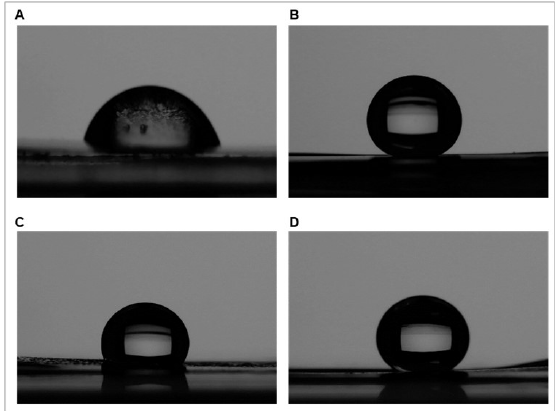
Figure 1. The water contact angle of poly(lactic acid) film ( A ) without the graphene/TiO 2 coating, ( B ) with the graphene/TiO 2 coating, ( C ) with the graphene coating, and ( D ) with the TiO 2 coating on the surface.